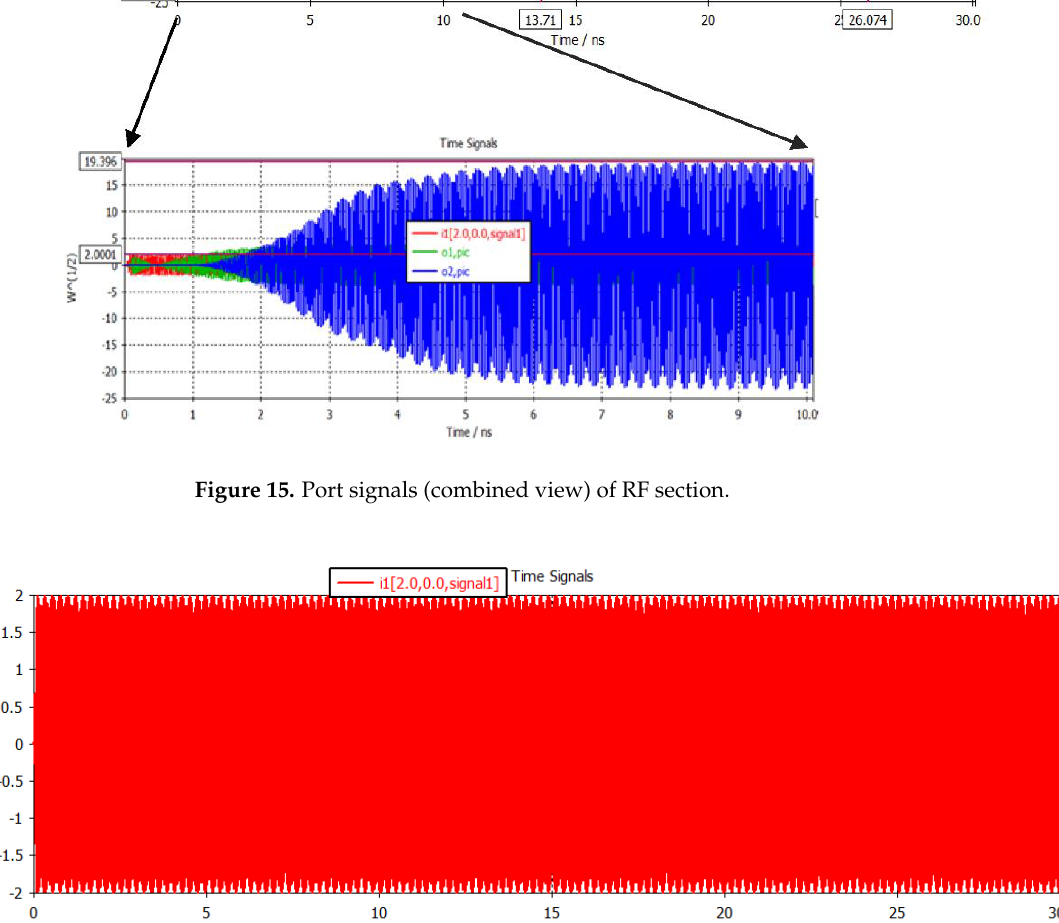
Figure 16. Input port signal of RF section.